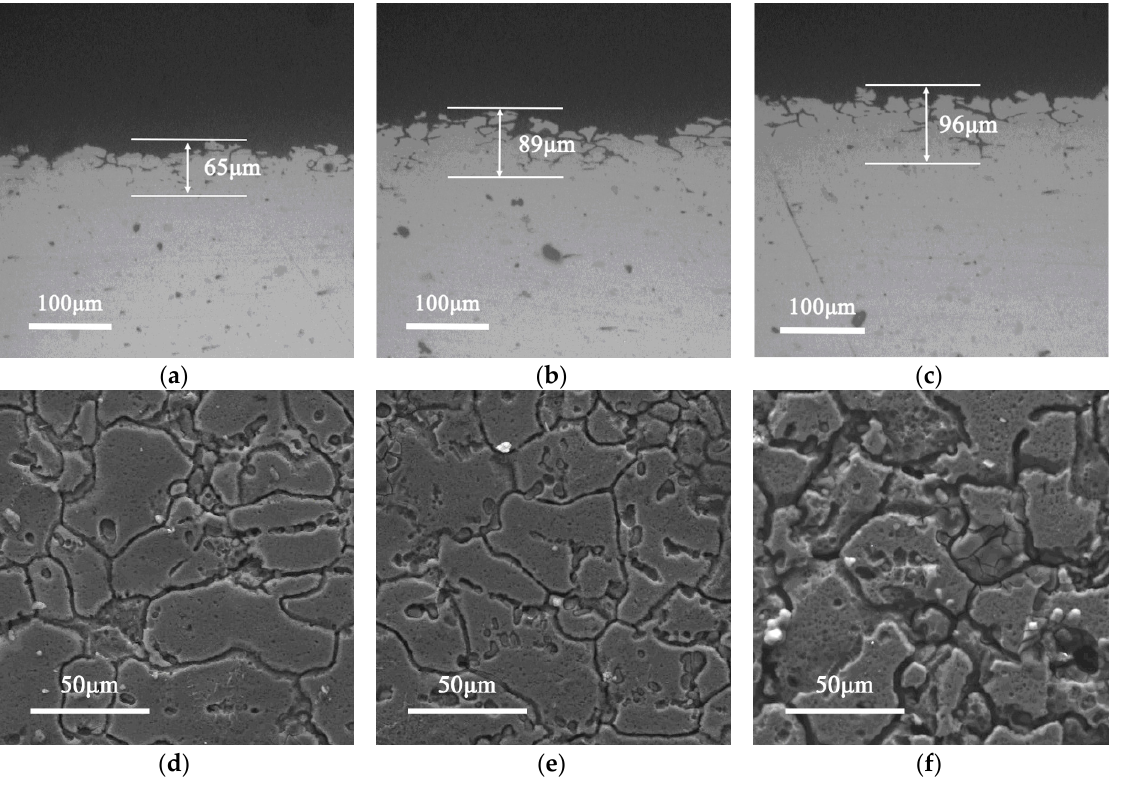
Figure 6. Typical IGC cross-sections and corresponding surface morphologies of the corroded Al-Mg-Si alloys with different Si contents: ( a , d ) alloy A, ( b , e ) alloy B, and ( c , f ) alloy C. Table 3. Maximum IGC depths for the Al-Mg-Si alloys at peak-aged conditions. Alloy